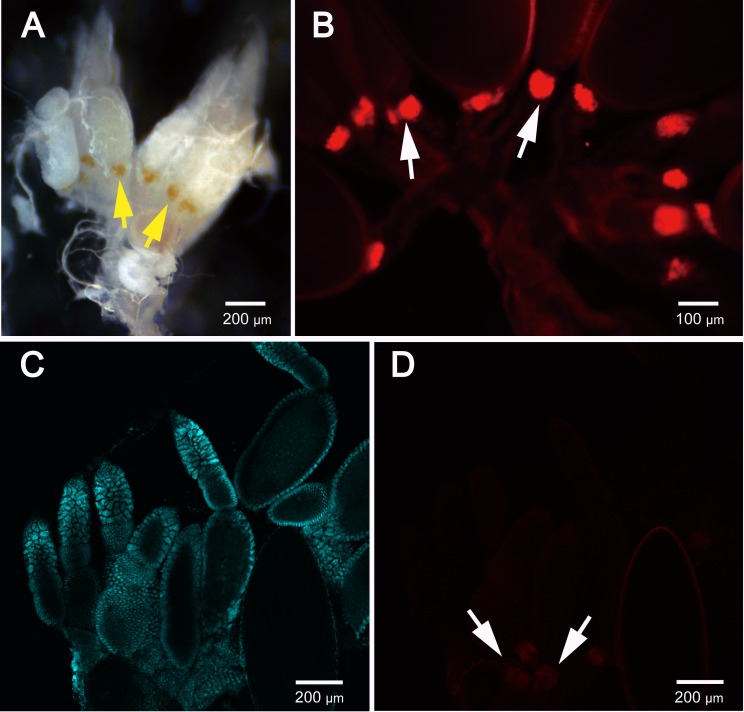
Micrograph of Blissus insularis female reproductive tracts.(A) Dissected female reproductive tracts of B. insularis with pedicel areas in yellow color (arrows) within ovarioles. (B) Epifluorescence micrograph of reproductive tracts without FISH, indicating the false signal by arrows, possibly caused by the melanin being deposited in the pedicel area. (C-D) Laser scanning confocal micrographs of reproductive tracts stained with DAPI and FISH.